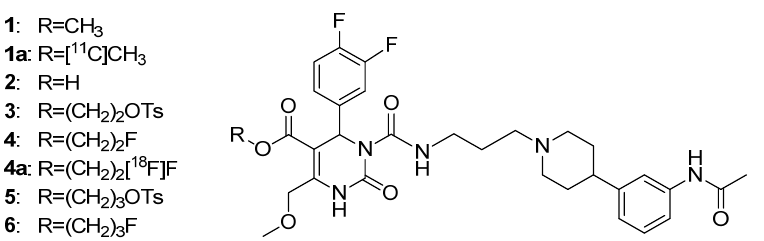
Figure 1. Structure of SNAP-7941 and derivatives 1a – 6